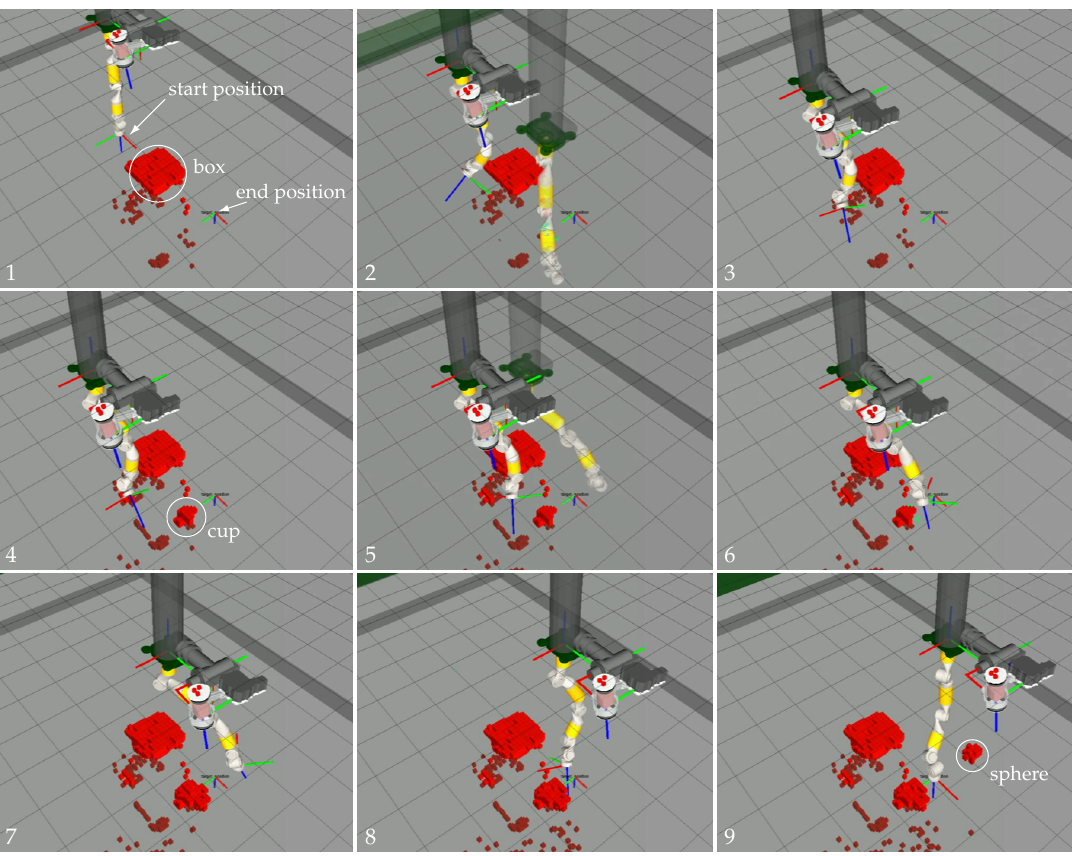
Figure 14. Sequence ( 1 – 9 ) of one of the trajectories of the eight DoF manipulators from Goal 1 to Goal 2. The shadow robot represents the simulation of the robot following the computed